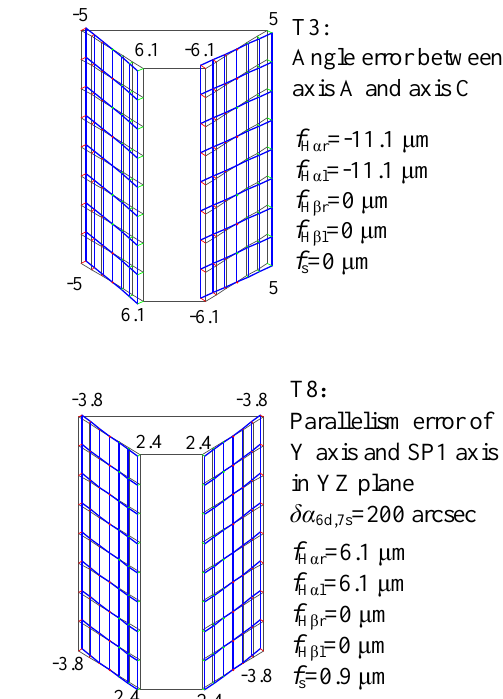
Figure 8. Deviations in tooth surface produced by assembly errors T1, T3, T6, and T8.